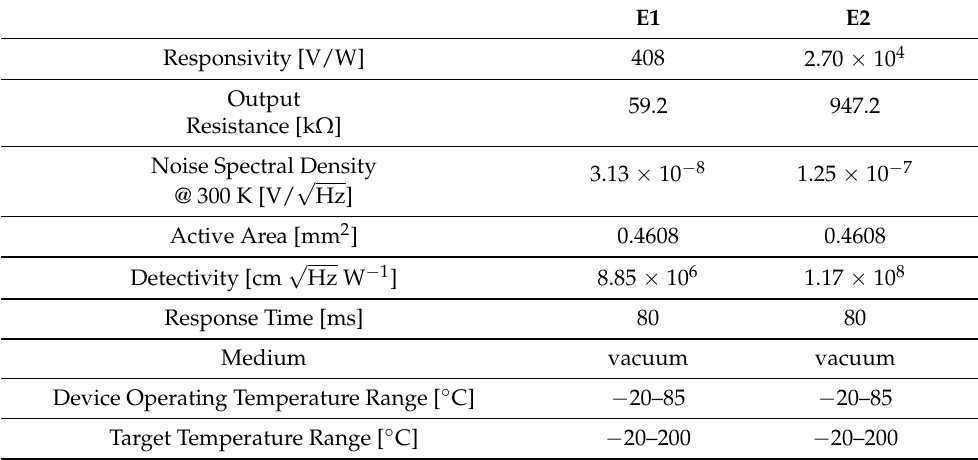
Table 5. Proposed thermopile sensors’